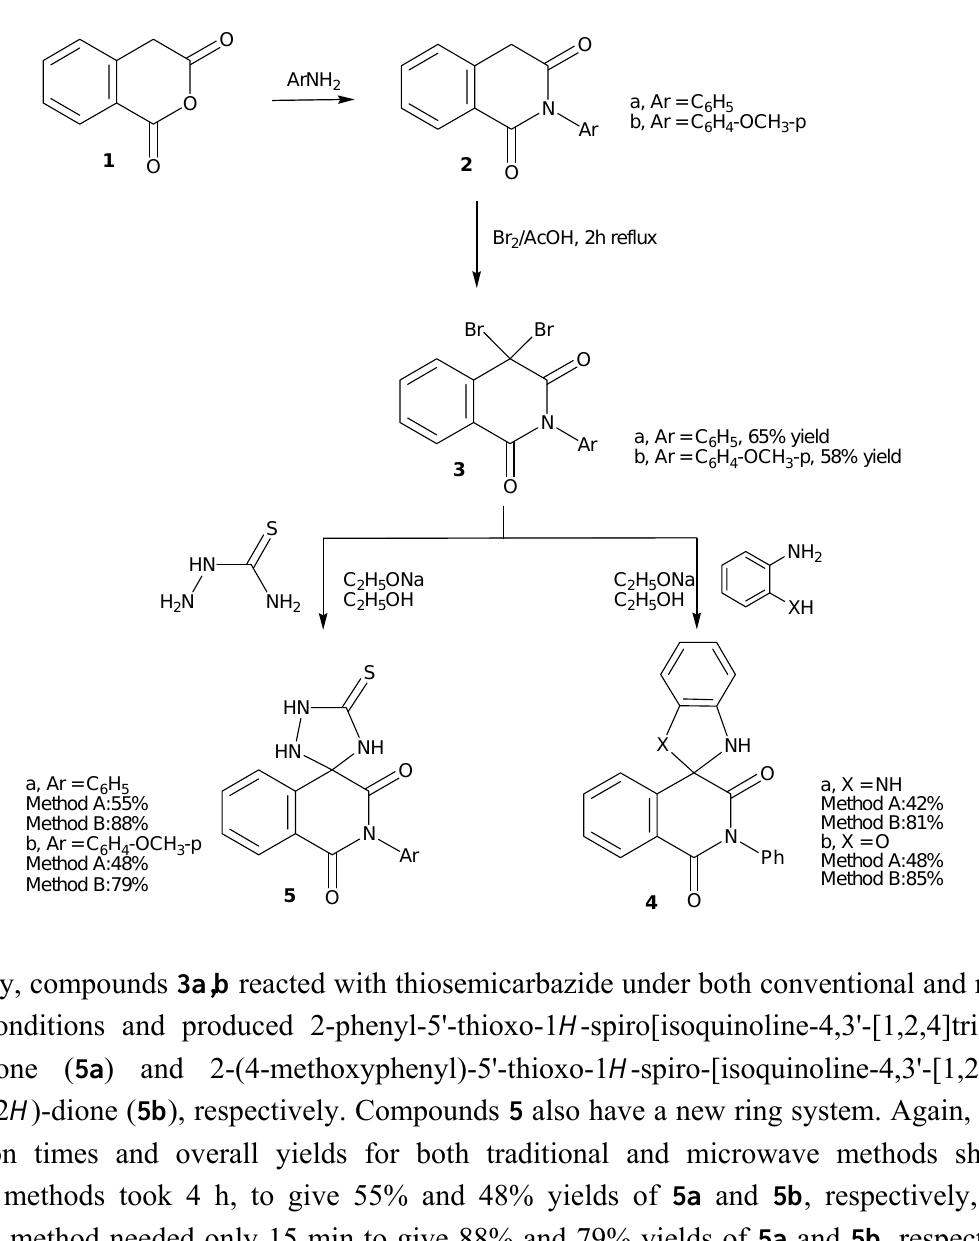
Scheme 1. Reactions of dibromohomophthalimides with binucleophilic reagents; synthesis of 4 and 5